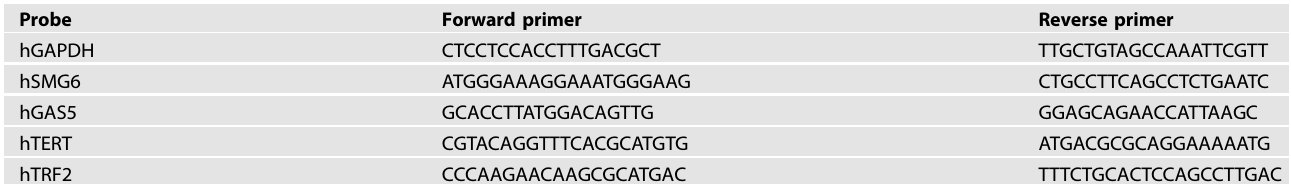
Table 1. List of primers for real-time qPCR, cloning, and sequencing. real-time